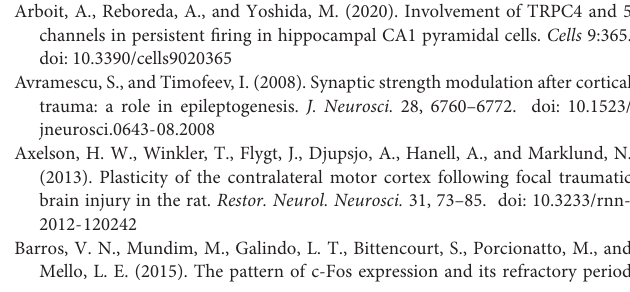
Supplementary Figure 1 | TRPC1 protein measurement 7 days after TBI. (A) Representative western blots (top) and summarized data (bottom) of TRPC1 protein in CA1 from sham and TBI mice, 7 days after procedure ( n = 6–7 mice per group). All data bars represent the mean ± SEM. ∗ p < 0.05 vs. sham. TRPC4/5 protein measurement 14 days after TBI. (B) Summarized data of western blot protein quantification from mice 14 days after TBI (normalized to the 7 day post-TBI group in Figure 2 ), in comparison of contralateral and ipsilateral tissue. ( n = 5 mice per group). All data bars represent the mean ± SEM. Supplementary Figure 2 | Subcellular localization of TRPC4 and M1R in the brain. Shown are mouse brain slices that have been stained with α -TRPC4 (red) and α -M 1 R (green) antibodies and DAPI (blue) for the (A) dentate gyrus (DG), (B) CA3, (C) CA1, and (D) parietal cortex layer 5. Hippocampus sub-regions demonstrate co-localization of TRPC4 and M 1 R in principal layer neuron soma, and strong expression of M 1 R in dendrites. Cortex layer 5 neurons show co-localization of TRPC4 and M 1 R in the soma. Scale bars: 100 µ m, 20 × magnification. Supplementary Figure 3 | The majority of active Layer 5 cortex cells 7 days after TBI are of primarily pyramidal neuron morphology. (A) Shown are images of contralateral and ipsilateral layer 5 parietal cortex imaged 7 days after TBI, with tdTomato (red) fluorescence denoting cFos activity. Scale bars: 100 µ m. (B) Shown is a reconstructed image of complete dentate gyrus coronal slice with tdTomato (red) fluorescence overlayed with DAPI (blue) from a cFos-TRAP mouse 7 days after TBI and activated with 4-OHT. Supplementary Figure 4 | Population Ca 2 + dynamics in mouse DGGCs 7 days after sham/TBI in response to 0.3 mM ACh. (A) Summarized number of DGGCs per brain slice that were responsive in showing at least 1 Ca 2 + influx event during 0.3 mM ACh. (B) Summarized area under the curve ( (cid:49) F/F × s) calculations of Ca 2 + events for control, cTBI, and iTBI cells. (C) Histogram population distribution of DGGCs with Ca 2 + influx according to peak amplitude. (D) Histogram population distribution of DGGCs according to Ca 2 + influx duration. For panels (C,D) black bars = control, gray bars = cTBI, striped bars = iTBI. ∗ p < 0.05 vs. control, † p < 0.05 vs. cTBI. Supplementary Figure 5 | Time-course of PTZ-induced motor seizure behavior outcomes in sham and TBI mice. Kaplan-Meier plot for mice exhibiting myoclonic jerking behavior (A) , forelimb clonus (B) , and tonic hindlimb extension (C) over time, from data shown in Figure 7E . M084 (10 mg/kg) was delivered 1 h prior to the once-daily dose of subconvulsant PTZ (35 mg/kg). Groups consist of sham (solid line), sham + M084 (dashed line), TBI (red dotted line), and TBI + M084 (dash-dot line). (D) Bars represent the latency to the three stages of PTZ-induced motor seizures upon challenge of mice with PTZ (60 mg/kg) 7 days after sham/TBI. Mice were given either vehicle or M084 (10 mg/kg) 30 min after procedure on day 0. † p < 0.05 vs. TBI + veh. n = 4–6 mice per group. Statistical comparisons were made with the Mann-Whitney U test. All data bars represent the mean ±